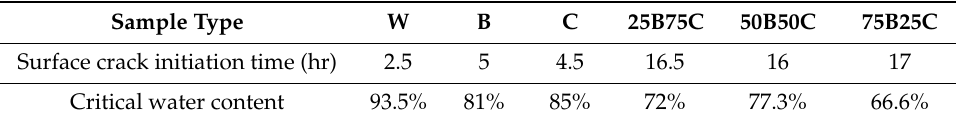
Table 3. Desiccation time and water loss at the onset of desiccation